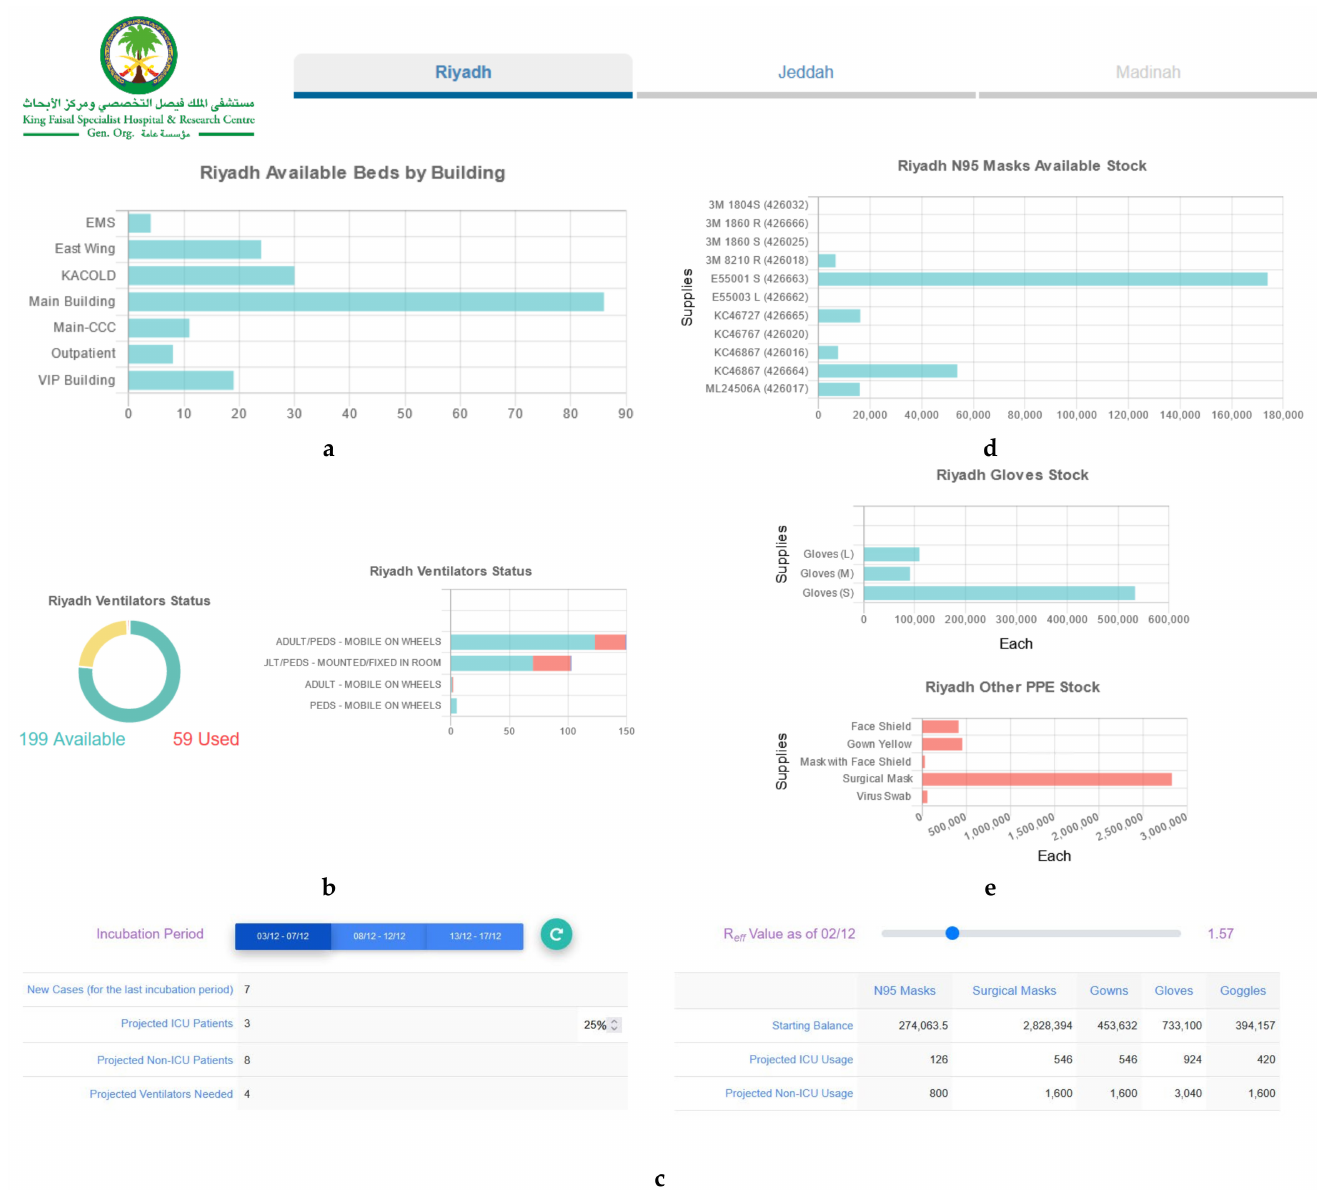
Figure 3. ( a ) Bed availability. ( b ) Ventilators’ utilization. ( c ) Projected PPE demands. ( d ) N95 Masks availability. ( e ) Other PPE supplies